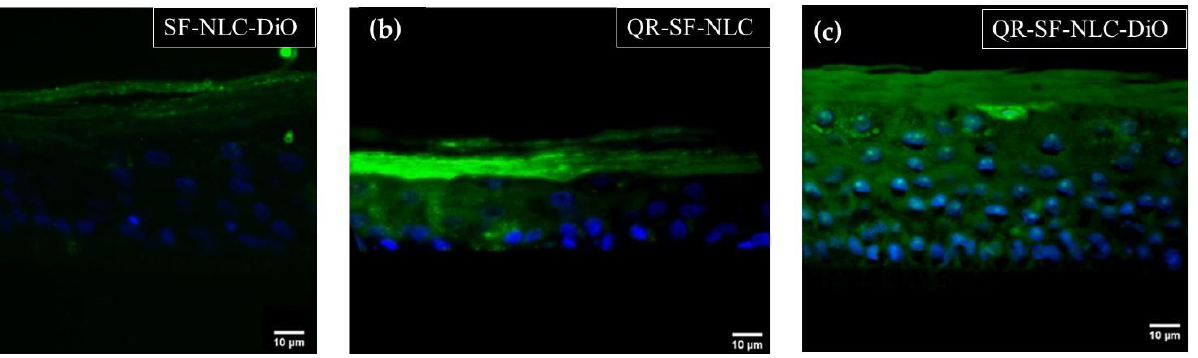
14 of 25 Figure 10. In vitro permeation profiles of QR-NPO-NLCs. Cumulative amounts released from NLCs in an RHE model. Plots were obtained from five experiments with each tested compound running under the same experimental conditions with three replicates. Error bars represent the mean ± SD value. The permeability studies of Tan et al. [67] of 0.5% QR-loaded lecithin – chitosan sys- tems on the dorsal skin of mice previously showed a significant amount of drug in the